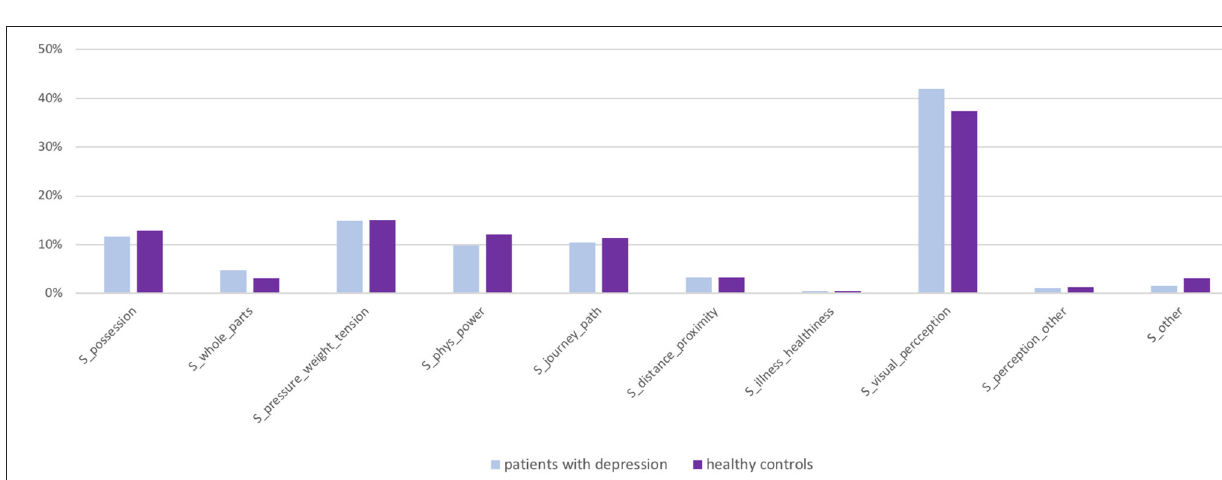
FIGURE 3 | Distribution of source domains of structural metaphors in the elicited speech production task: group